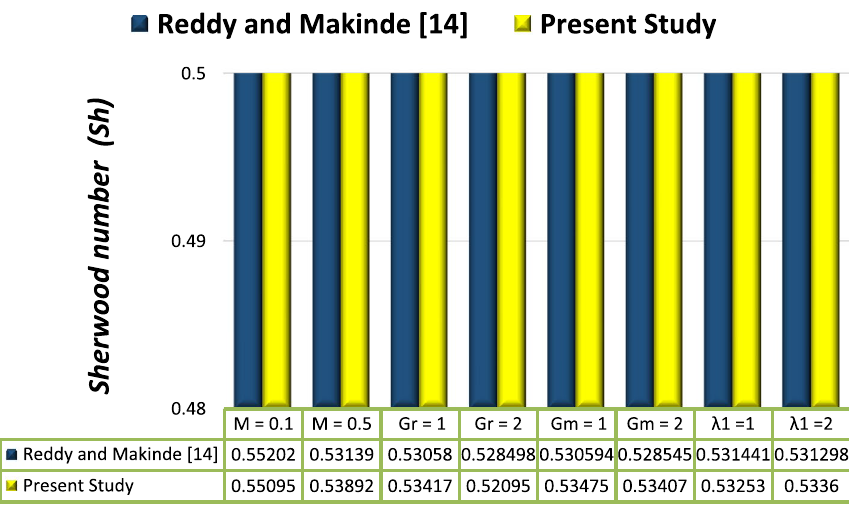
Figure 11. Comparison between previous work.